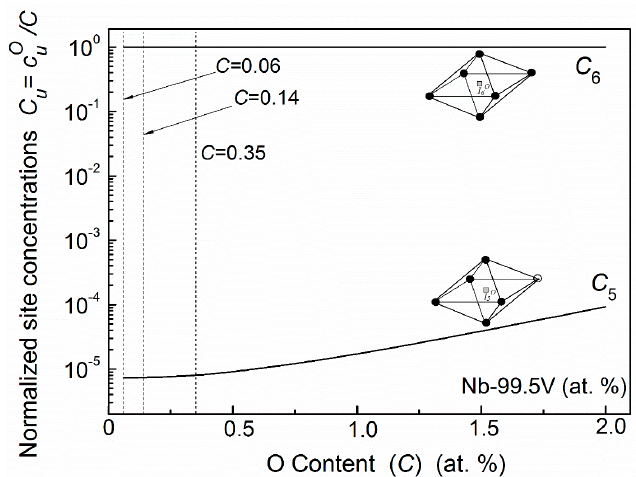
Figure 11. Normalized distribution of oxygen atom in Nb–99.5V (at. %) alloys with different oxygen content. ( ○ —Nb atoms, ● —V atoms).